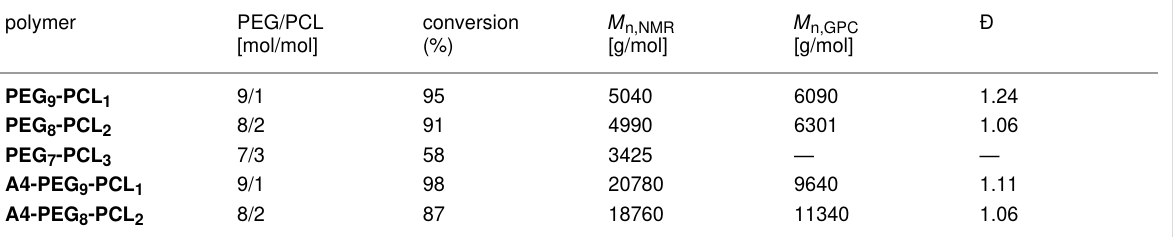
Table 1: Summary of properties of the copolymers obtained by ATRP. PEG/PCL macromonomers molar ratio, conversion, number average molecu- lar weight obtained by 1 H NMR ( M n,NMR ) and GPC ( M n ,GPC ), and dispersity Ð (by GPC) are listed in the